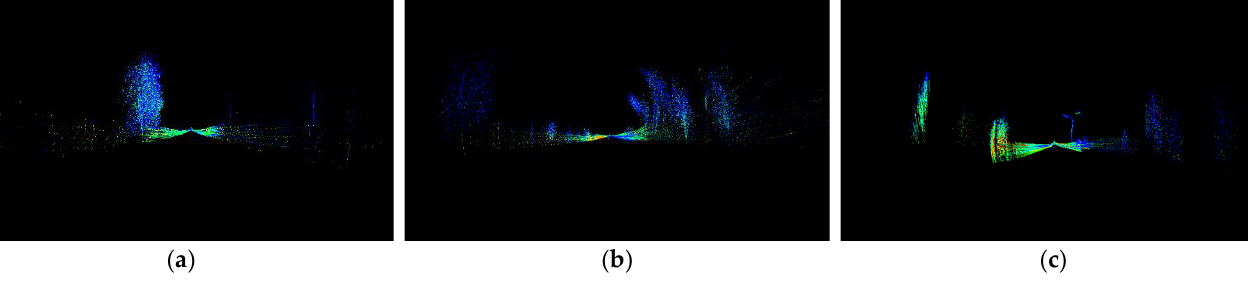
Figure 12. Point cloud image scene 8: Rappahanock ( a ) Picture 1, ( b ) Picture 2, ( c ) Picture 3.